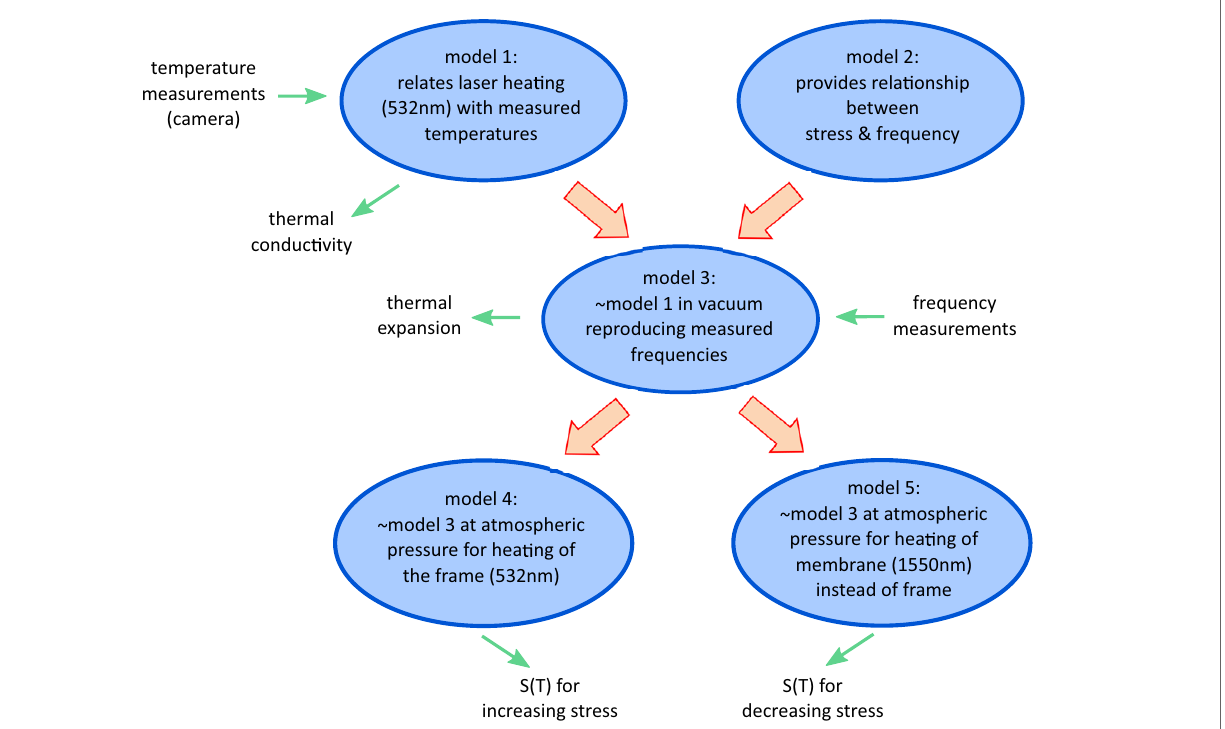
FIGURE 2 | Schematic of the different models 2 used, of their relationship, and the results: Model 1 (at atmospheric pressure) relates heating the membrane frame with the 532nm laser to the temperatures of membrane and frame by fitting the thermal conductivity of the membrane. Model 2 is a purely theoretical model providing the relationship of resonance frequency and stress. Model 3 (in vacuum) combines models 1 and 2 to match the frequencies observed for heating the membrane frame by fitting the thermal expansion coefficient of the membrane. Model 3 under atmospheric pressure and for heating the membrane frame provides a stress increase as a function of temperature (model 4) and a stress decrease as a function of temperature (model 5) for heating the membrane directly.